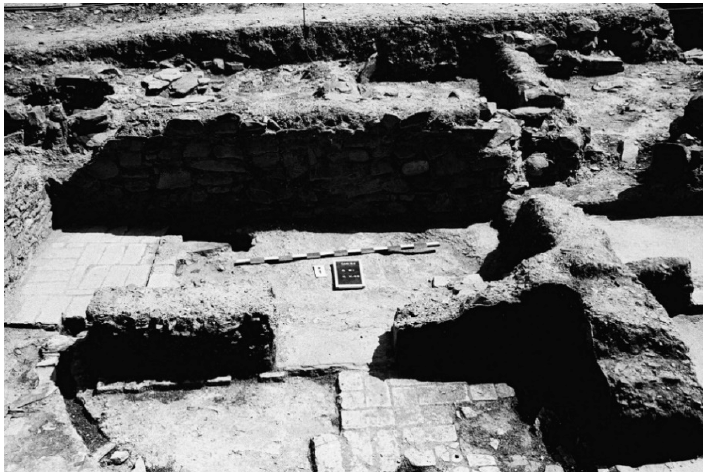
Figure 9. Mértola—house n. 10 (kitchen). Photo took by author.